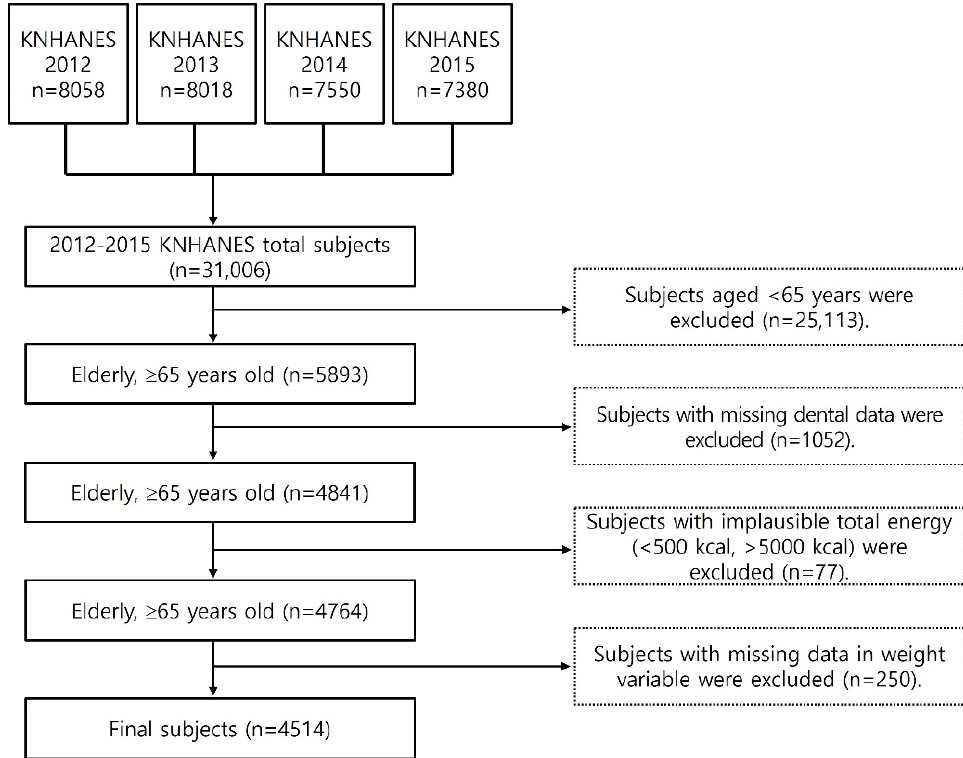
Figure 1. The flow chart for subject samples of this study. Six segments were evaluated for each mouth. Upper right second molar (#17), upper right first molar (#16), upper right central incisor (#11), upper left first molar (#26), upper left second molar (#27), lower right second molar (#47), lower right first molar (#46), lower left central incisor (#31), lower left first molar (#36), and lower left second molar (#37) were designated as index teeth. The CPI scores range from 0 to 4 and are defined as: 0, healthy; 1, bleeding on gentle probing; 2, dental calculus and bleeding; 3, shallow pockets of 4 or 5 mm; and 4, deep periodontal pockets of 6 mm or more. The lower the value, the better the periodontal condition [26]. The highest CPI score was 4 points, which was based on the cases where two or more measurable residual teeth per segment were